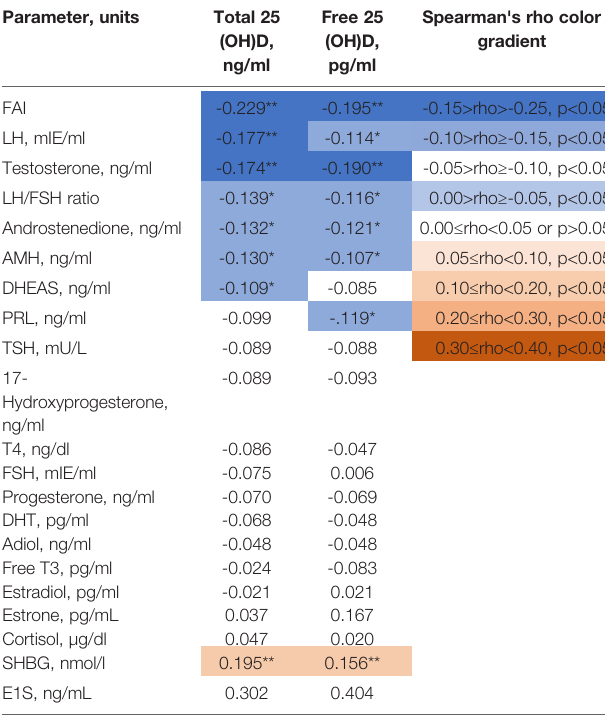
TABLE 2 | Bivariate correlations between total and free 25(OH)D and selected hormones sorted in ascending order according to spearman ’ s rank